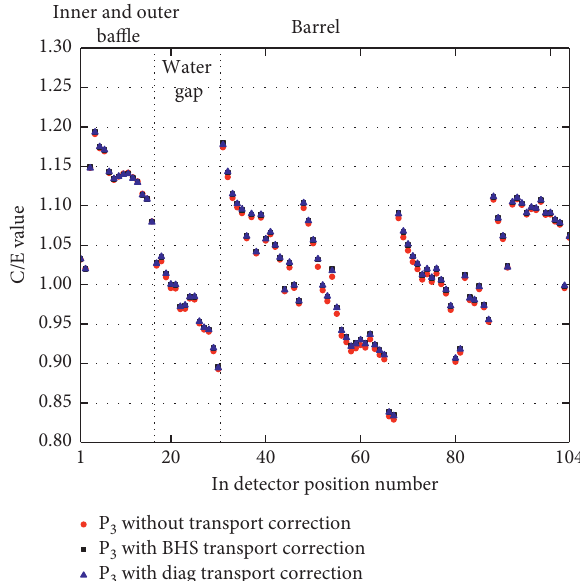
Figure 21: Comparison of P 27 Al(n, α ) 115m In detector.